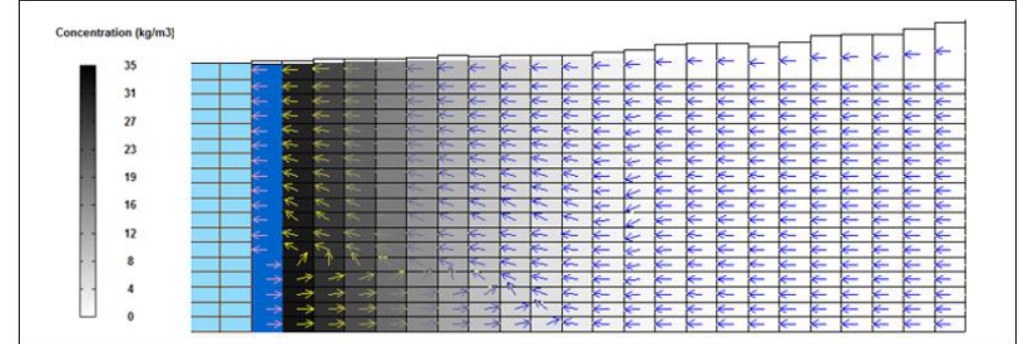
Figure 17. Location of the seawater intrusion in the area of Ambabbo locality in 2100 under scenario RCP 2.6. NS vertical section. Concentration in kg/m 3 .